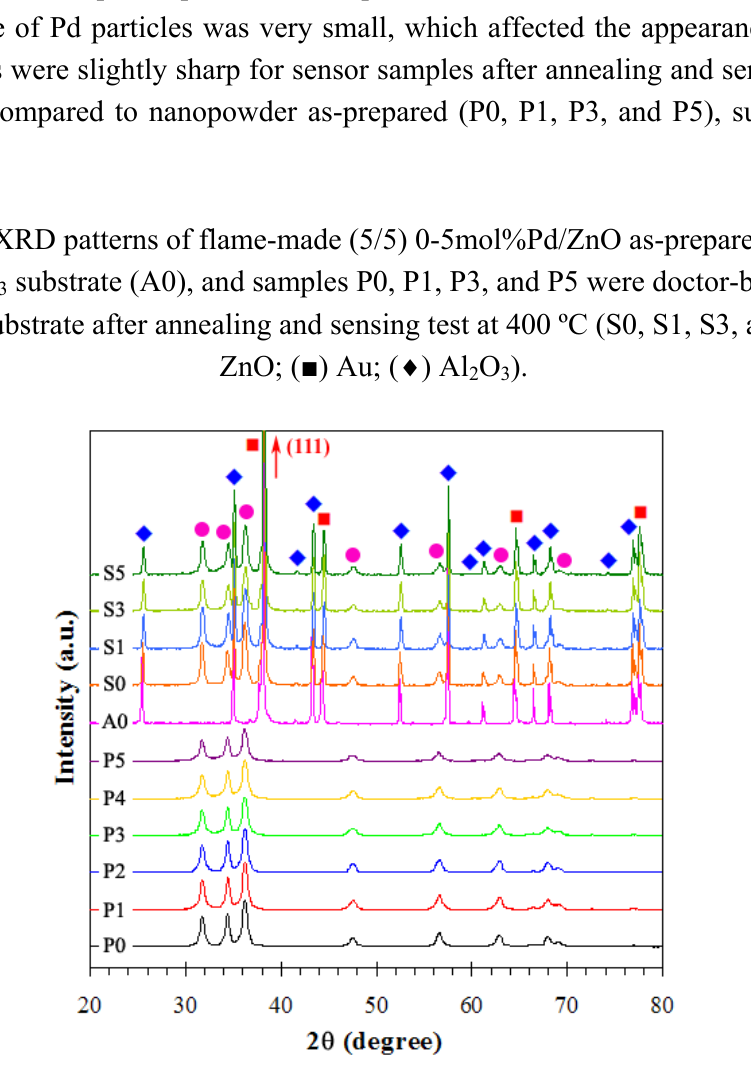
Figure 3. XRD patterns of flame-made (5/5) 0-5mol%Pd/ZnO as-prepared (P0-P5), O substrate (A0), and samples P0, P1, P3, and P5 were doctor-bladed on Au/Al 2 3 Au/Al O substrate after annealing and sensing test at 400 ºC (S0, S1, S3, and S5) (( ● ) 2 3 ZnO; ( ■ ) Au; ( ♦ ) Al